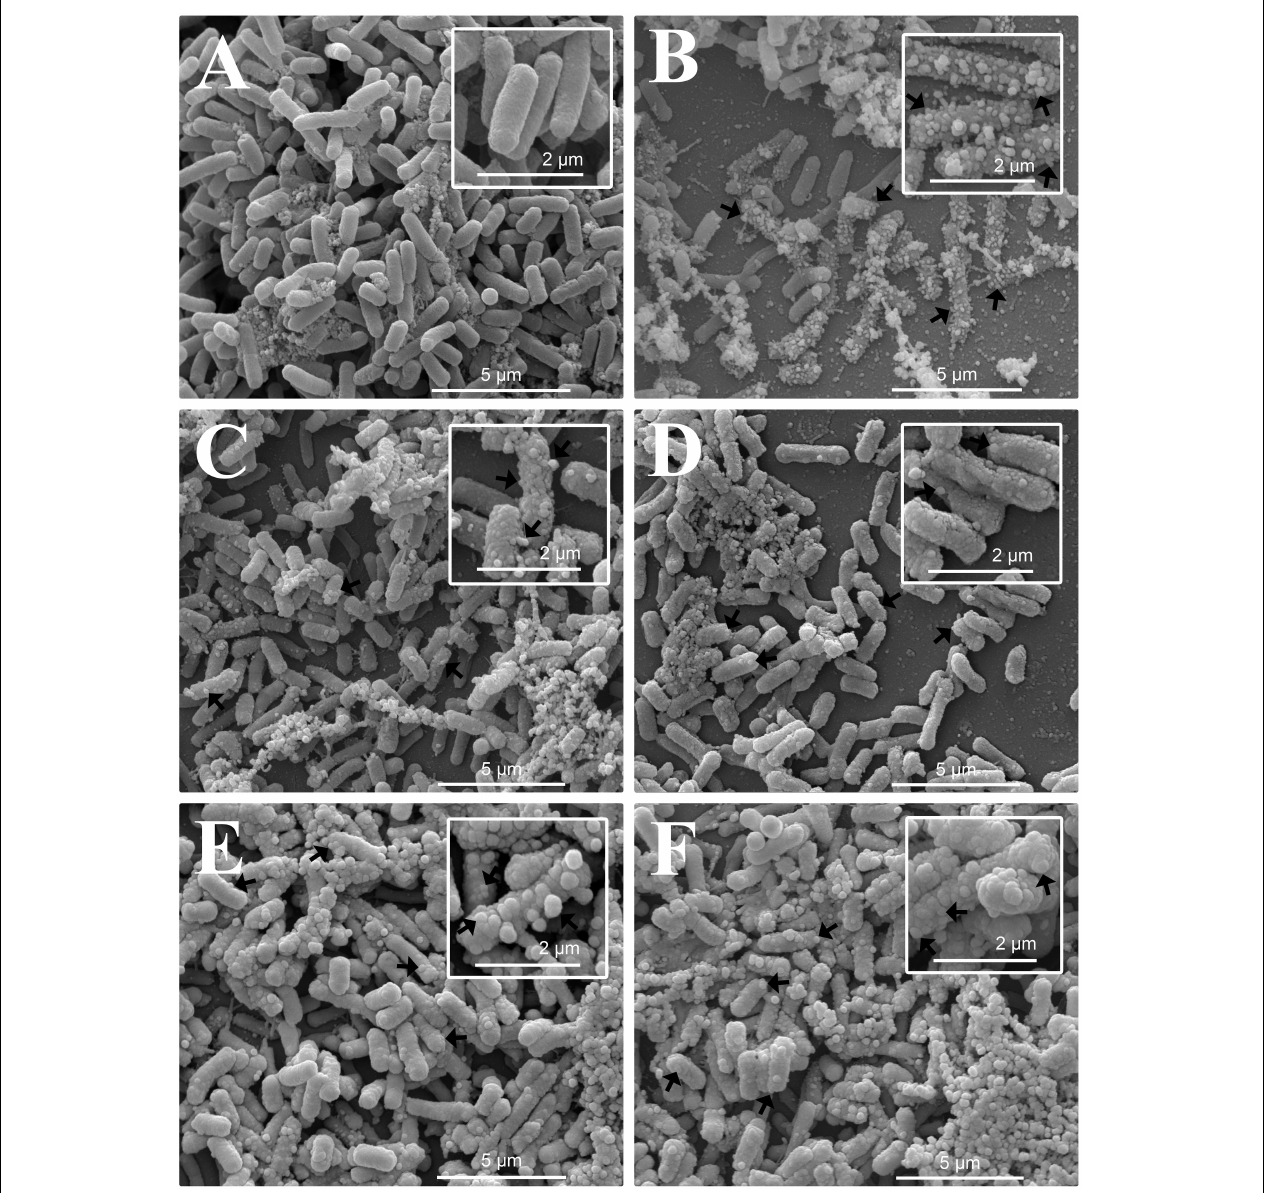
FIGURE 6 | Scanning electron micrographs of the antibacterial effect of the oregano-derived antimicrobials and bioAgNP individually and in combination against E. coli ATCC 25922. Bacteria were exposed for 30 min to subinhibitory concentrations of the antimicrobials. (A) Untreated control. (B) OEO-treated cells. (C) Car-treated cells. (D) Thy-treated cells. (E) BioAgNP-treated cells. (F) Bacterial cells treated with the combination of Thy plus bioAgNP. Micrographs (A–F) show bacterial cell density, size, shape, and surface morphological changes (15,000 × ). Inset images show in detail the morphological alterations of treated cells and typical cells of the untreated control (30,000 × ). Arrows: morphological changes (surface protrusions), cellular debris and size-changed